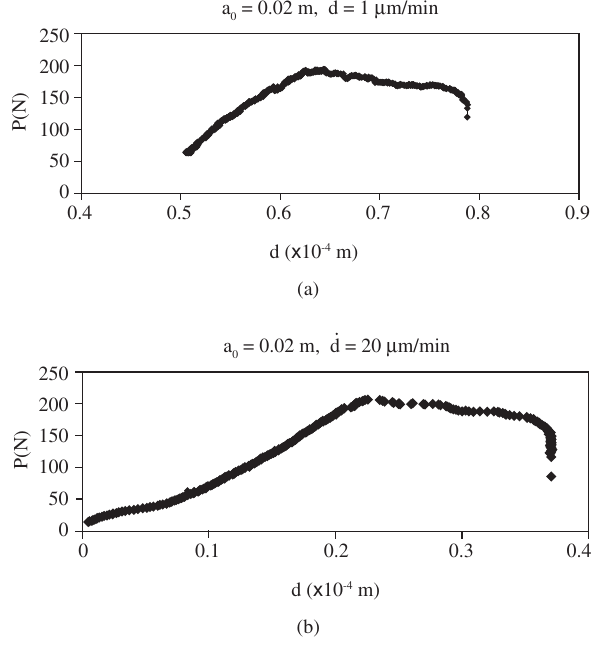
d. = 1 µ m/min and b)